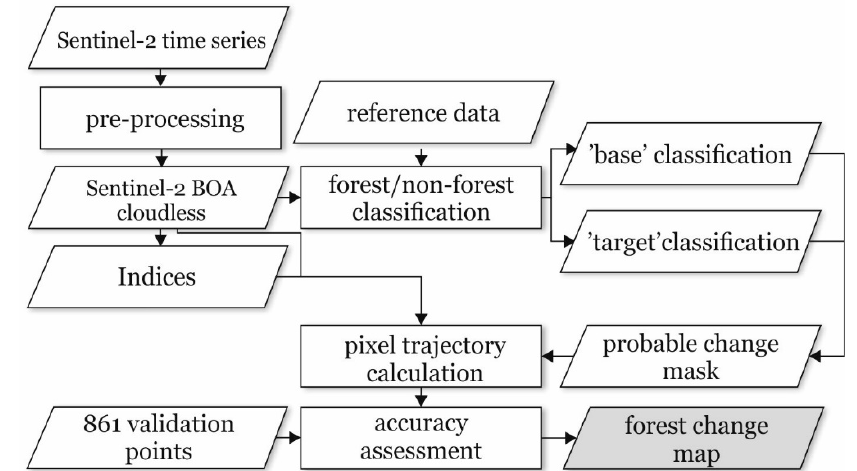
Figure 3. Workflow used in this study.